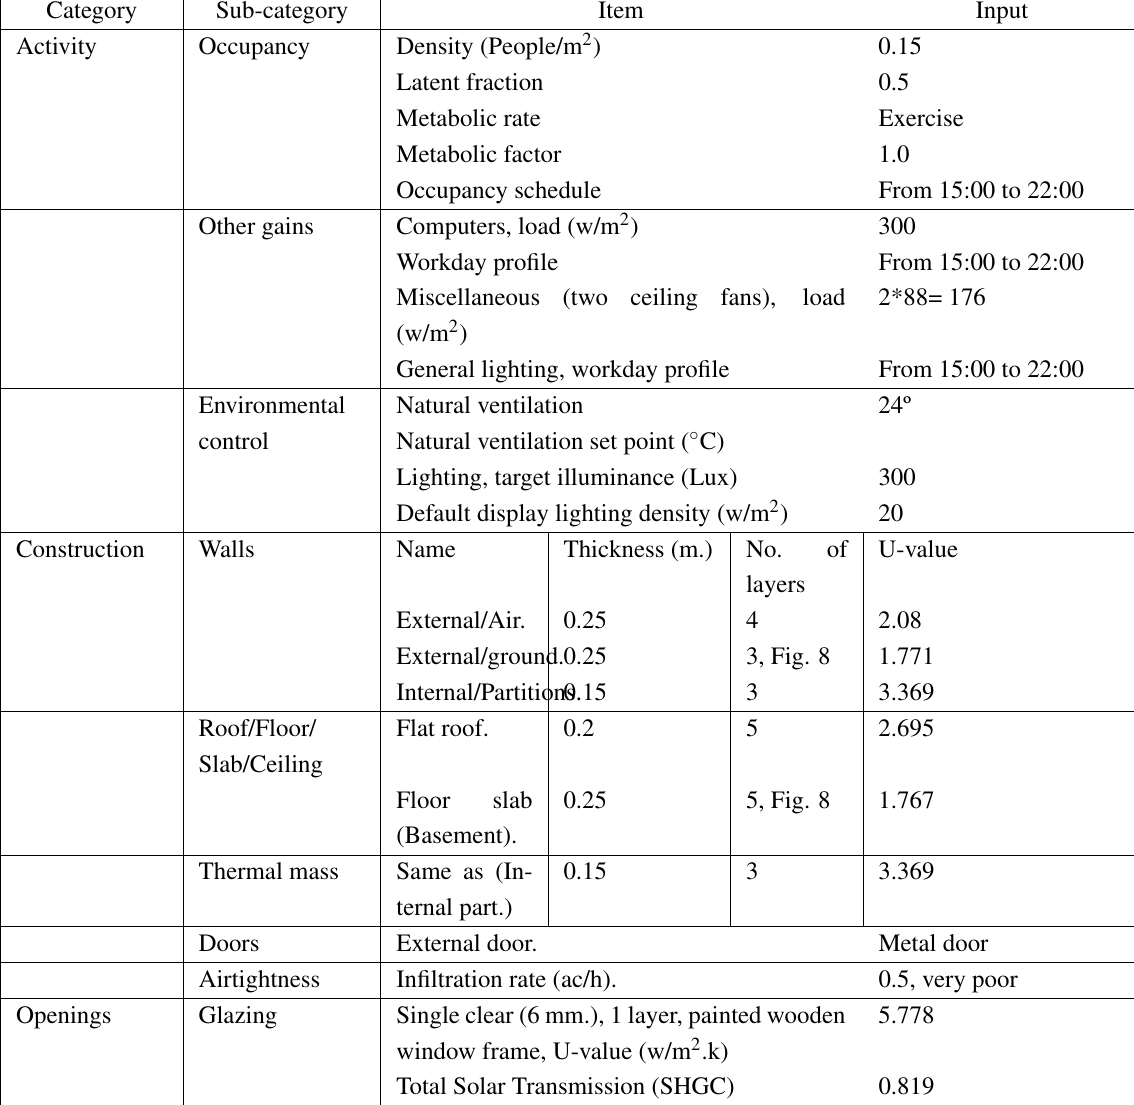
Table 3. Customized inputs for the building model calibration in